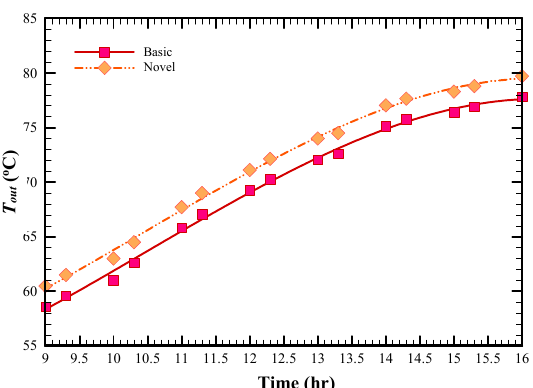
Figure 9. Variation of outlet temperature for a basic system without a turbulator and novel PTSC equipped with a turbulator and filled with nanofluid at ϕ = 0.019% and Re = 5000 versus different times of day.